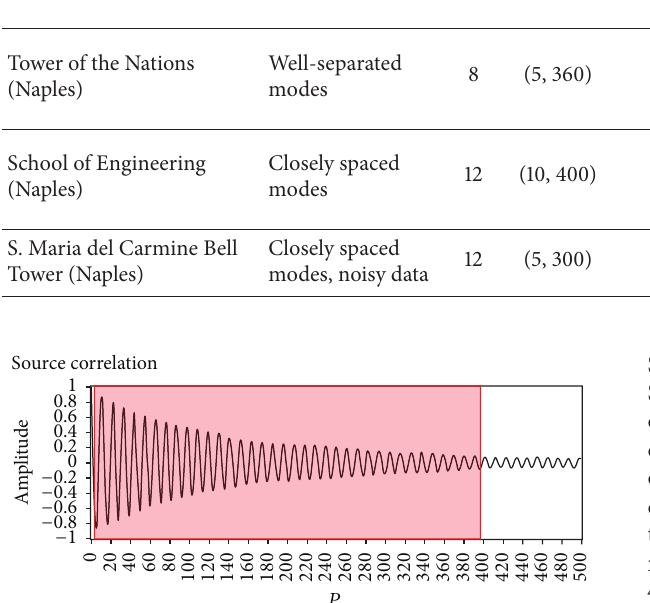
similar results have been obtained considering as reference estimates those provided by the FDD method). Figure 5 shows that the proposed rule is able to properly evaluate the optimal setting of 𝑝 even in the case of real